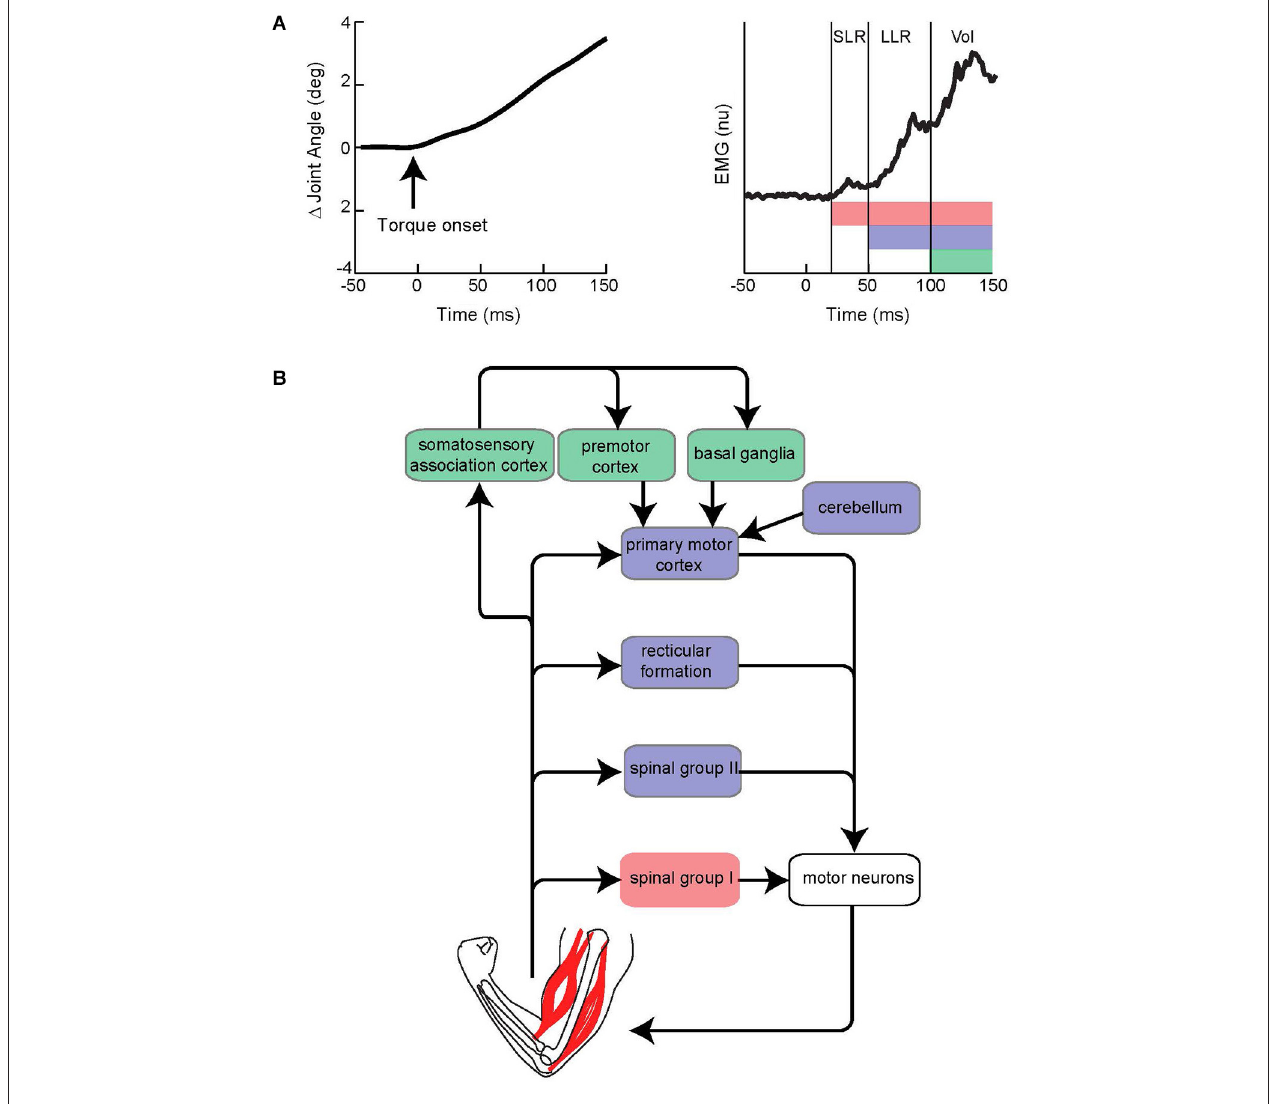
purple, and green horizontal bars depict the neural process that contribute to the different epochs. Note the neural contributions continue throughout the perturbation and overlap in time. (B) Simplified diagram of neural contributors to the different epochs of evoked activity. Colored boxes correspond to colored bars in panel above. Note that several pathways may be involved for a particular